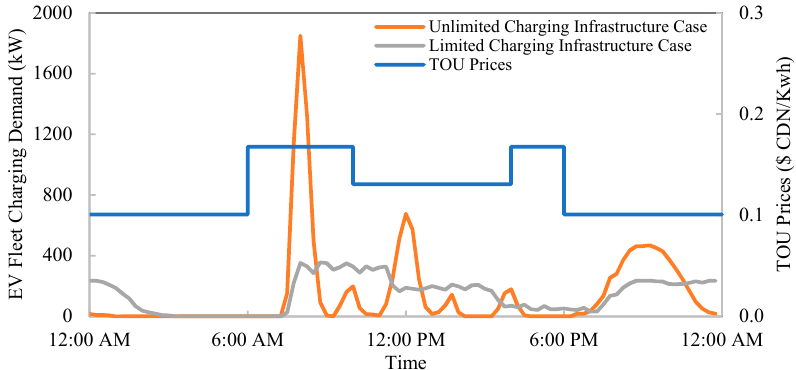
Figure 8 . Comparison of uncontrolled EV fleet charging demand profiles between limited and unlimited charging infrastructure scenarios.